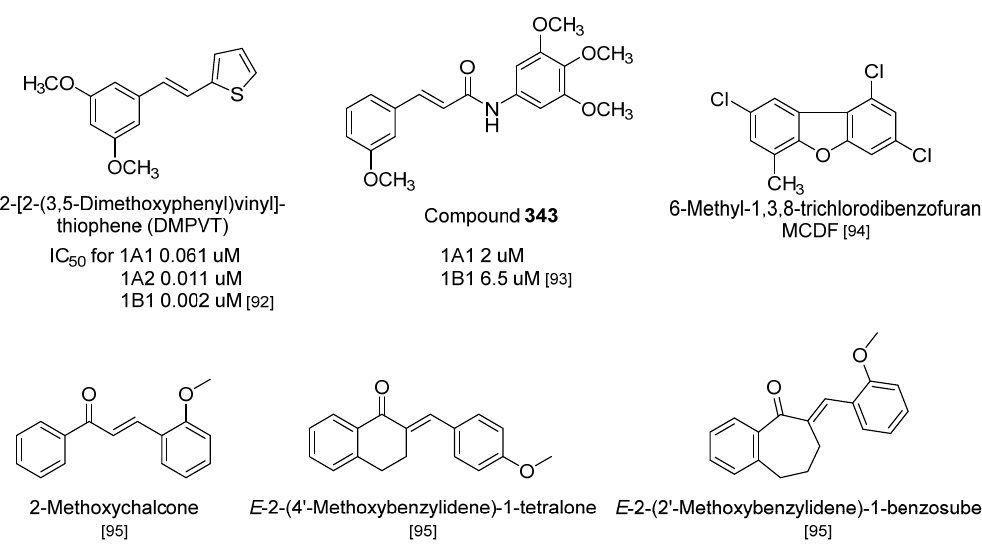
Figure 9. Other synthetic